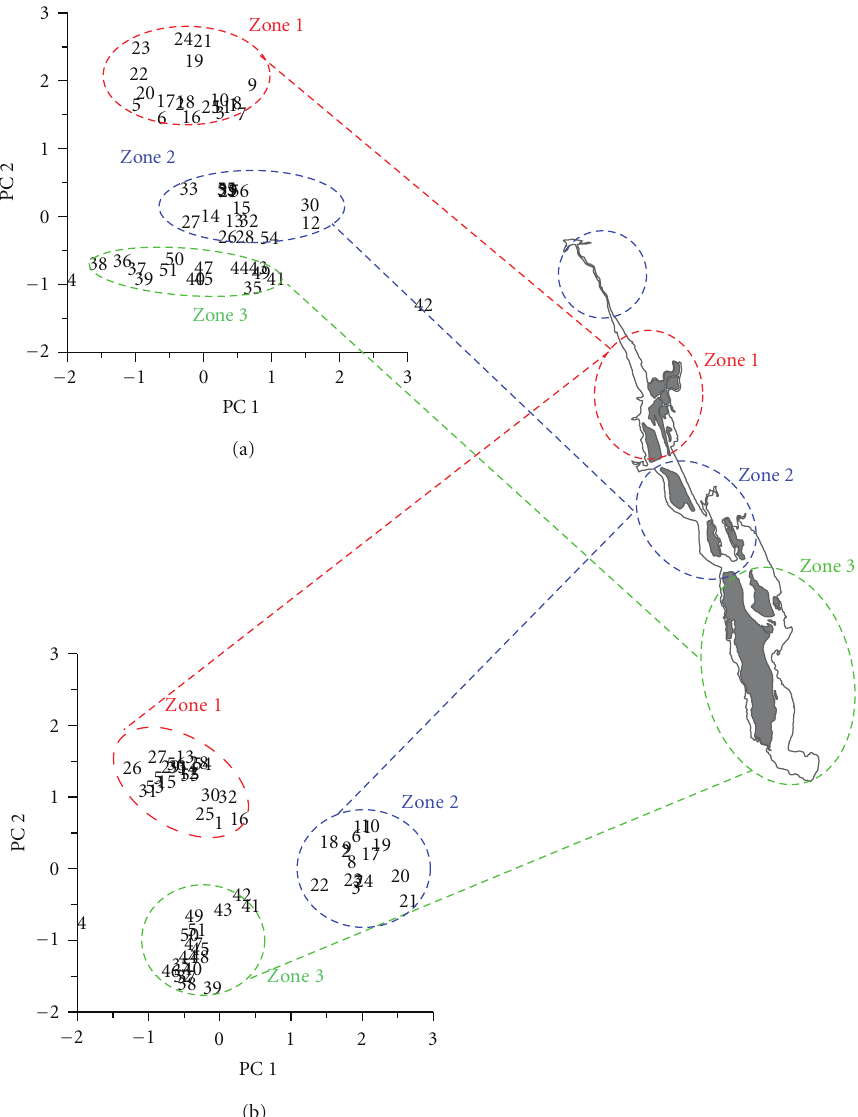
Figure 5: Principal component analysis during monsoon (a) and premonsoon